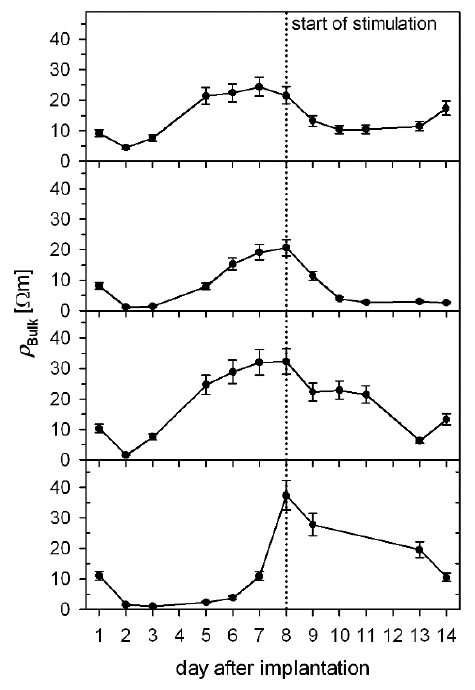
Figure 9: Individual plots of the four bipolar electrodes summarized in Figure 8. Despite the qualitatively similar pictures, the plots suggest a strongly individual behavior. Missing experimental points were caused by data-logging problems with the impedance